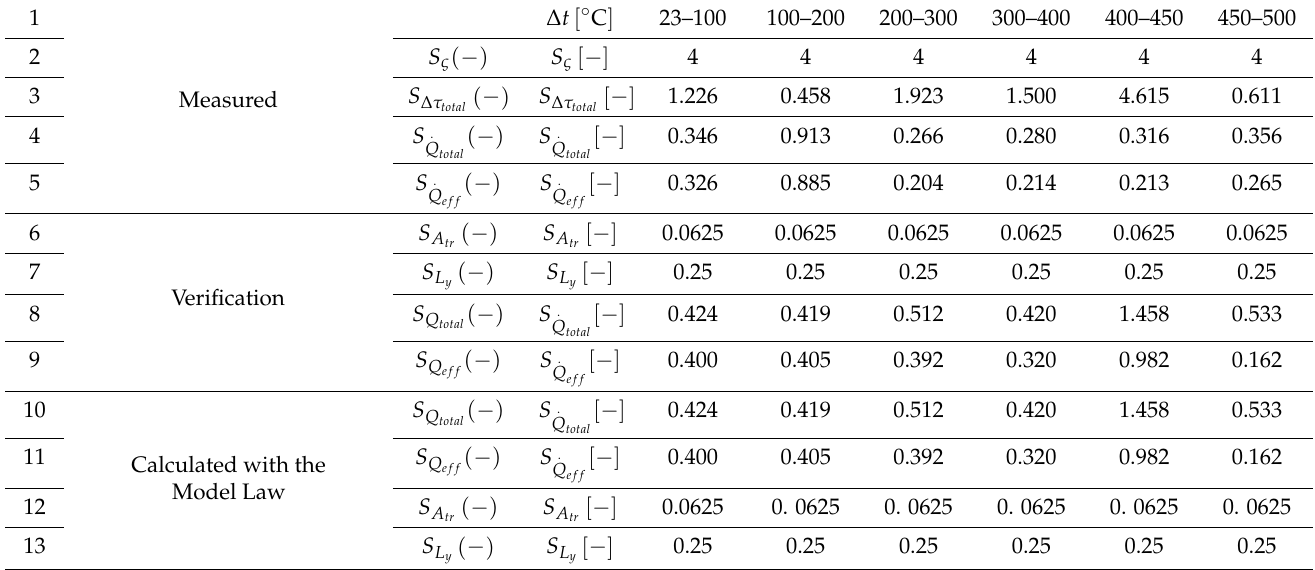
Table A11. The 1:4/1:1 unpainted model/prototype.